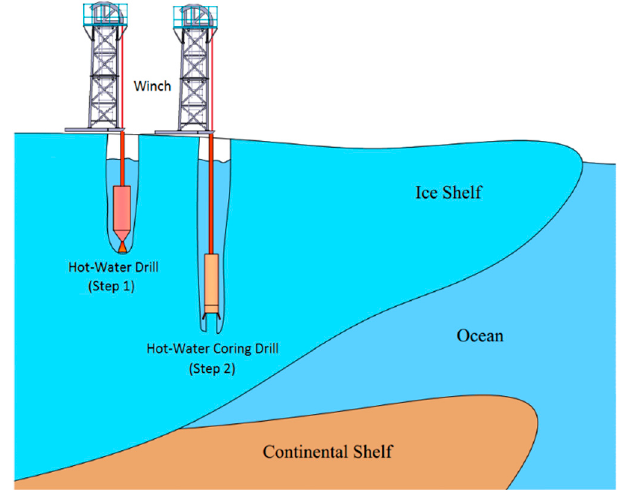
Figure 3. Working schematic of hot water ice-coring drilling.